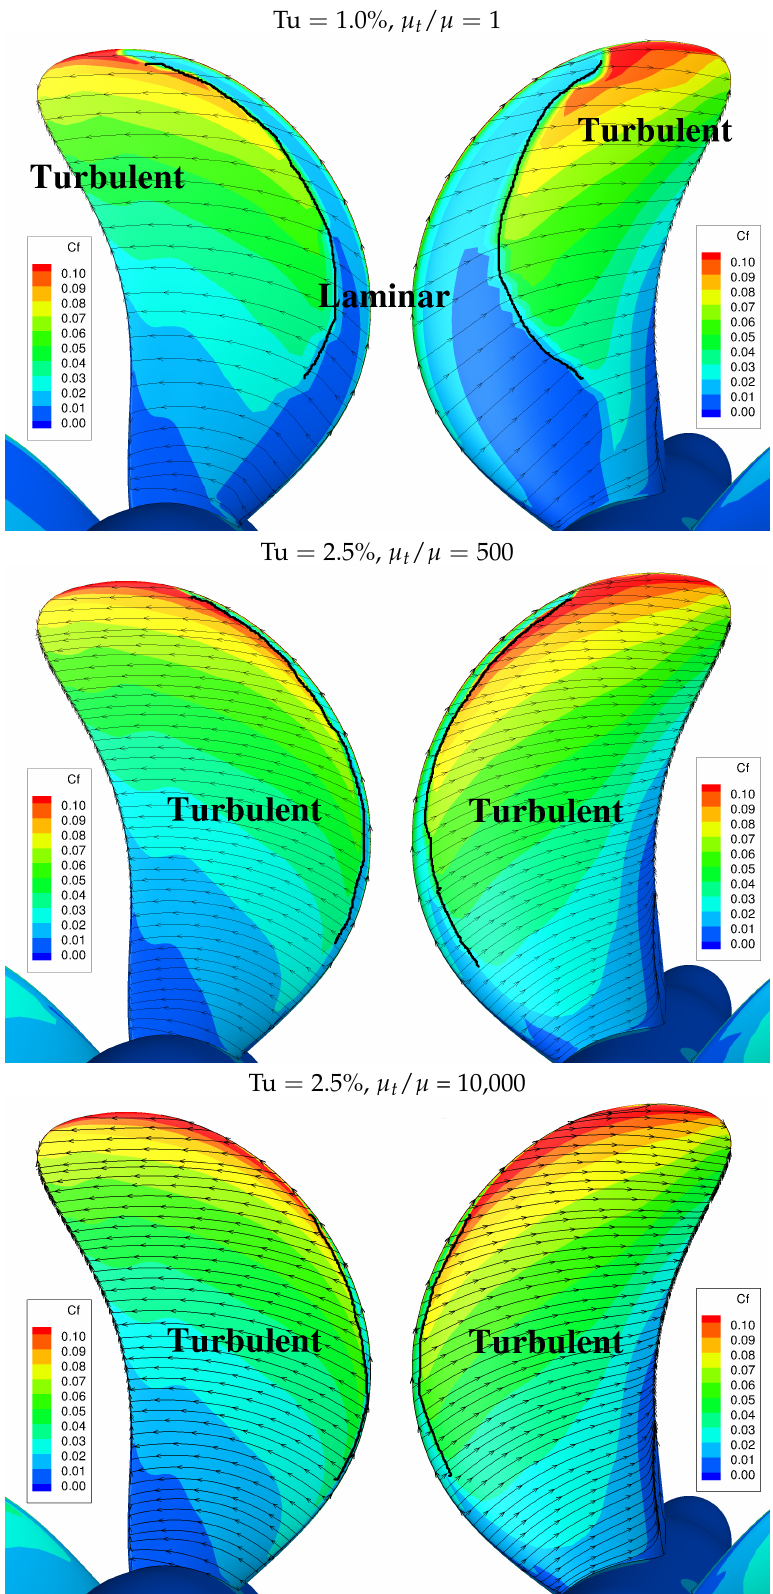
Figure 13. Influence of the inlet turbulence quantities on the propeller blade flow. Limiting stream- lines and skin friction coefficient using the γ − ˜Re θ Pressure side ( left ) and suction side ( right